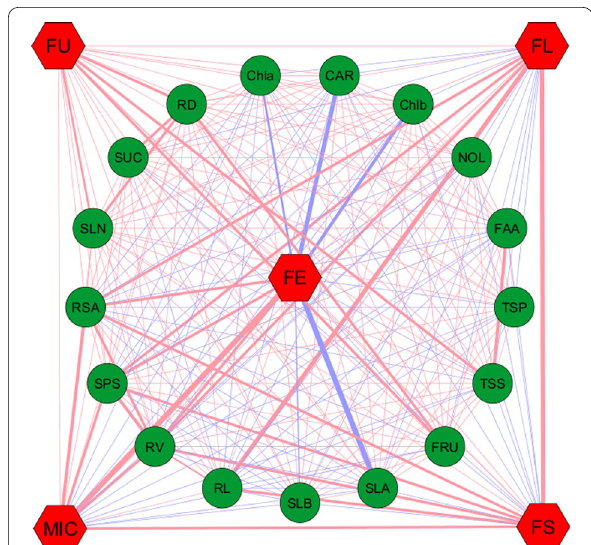
Means not sharing a letter in common with in a column differ significantly at 5% probability level. ns (mm), FU